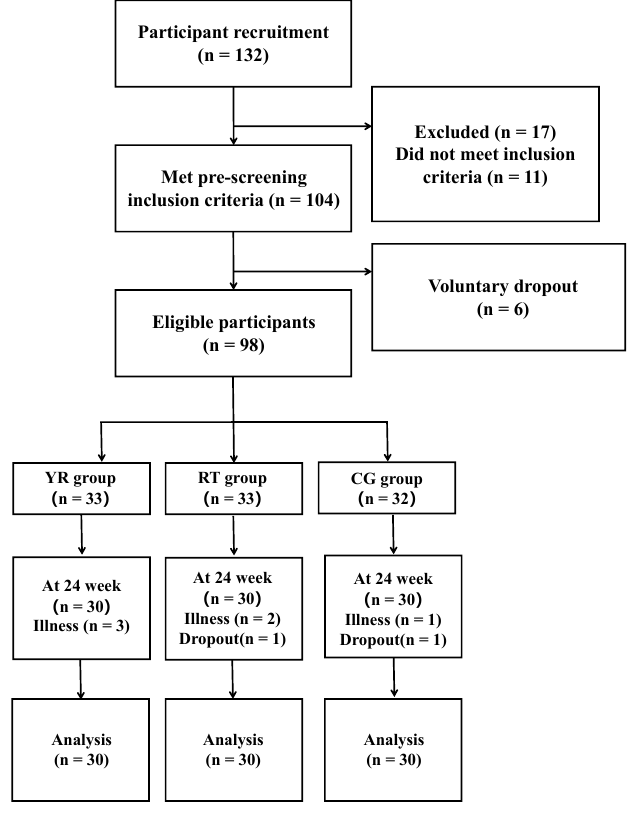
Figure 1. Participant flow